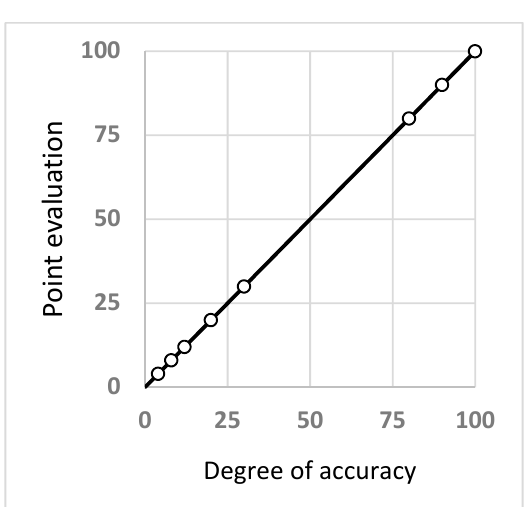
Figure 3. Dependence of the number of points on the number of assembly groups. Source: authors.